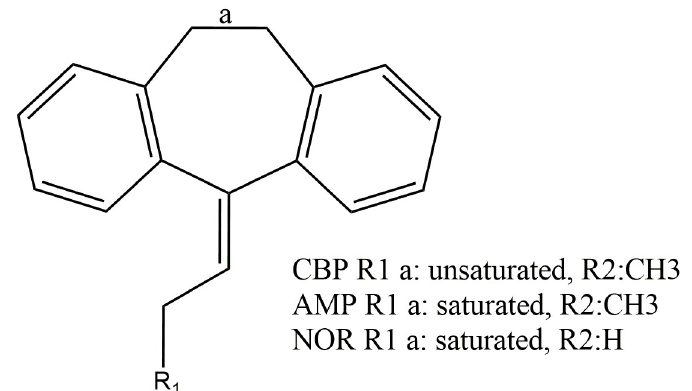
Figure 1. Chemical structure of cyclobenzaprine (CBP), amitriptyline (AMP) and nortriptyline (NOR).